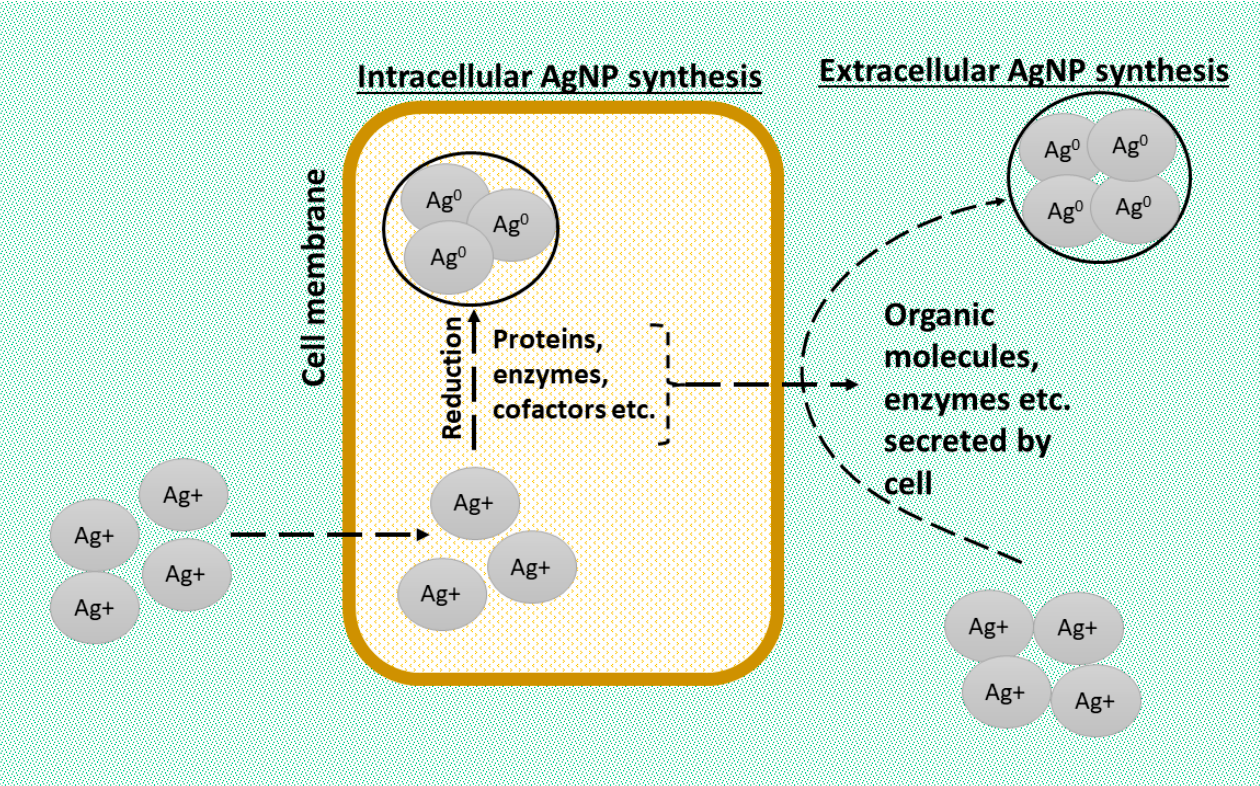
Figure 2. The figure depicts intracellular and extracellular biogenic synthesis of AgNPs mediated by biological